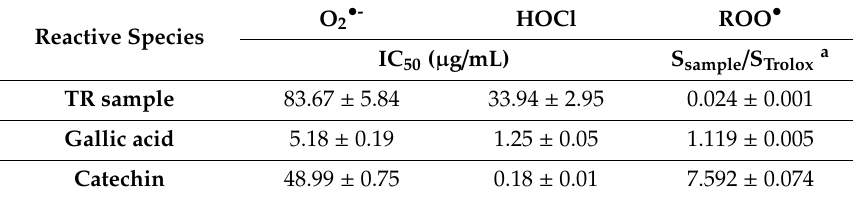
Table 3. Superoxide (O 2 • - ), hypochlorous acid (HOCl) and peroxyl radical (ROO • ) scavenging activities of Tinta Roriz (TR) subcritical water extract obtained at 250 ◦